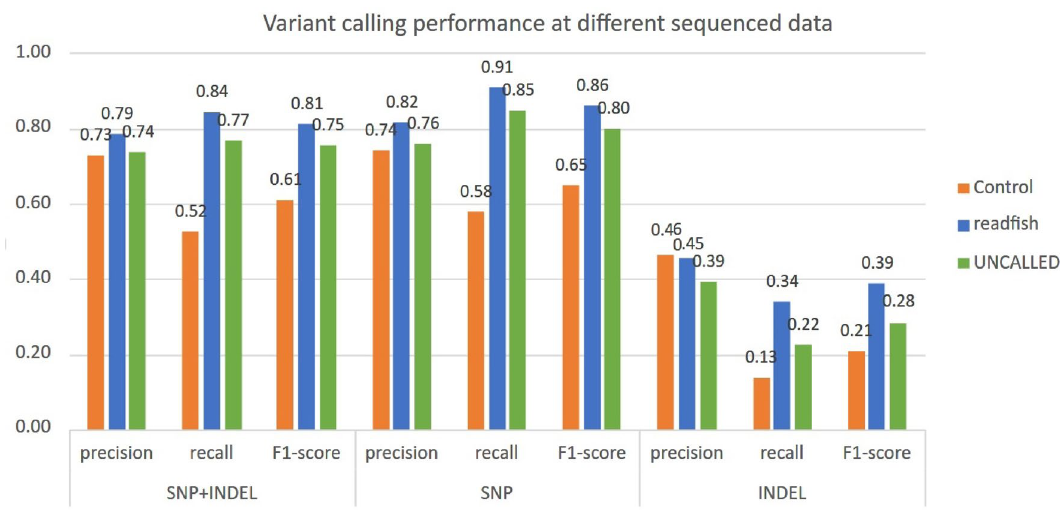
Figure 3. Performance of variant calling at different samples. Precision, recall and F1-score for SNP, INDEL and SNP + INDEL variants called via the Clair3v0.1-r12 guppy5 model at samples of the Control run, and adaptive sequencing run of readfish and UNCALLED.